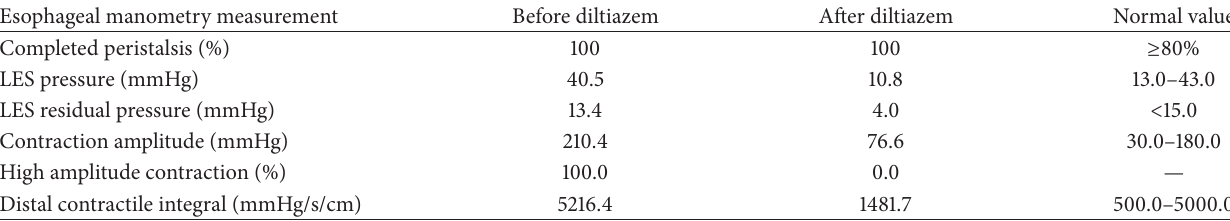
Table 1: Changes in esophageal motility after 30 mg diltiazem QD